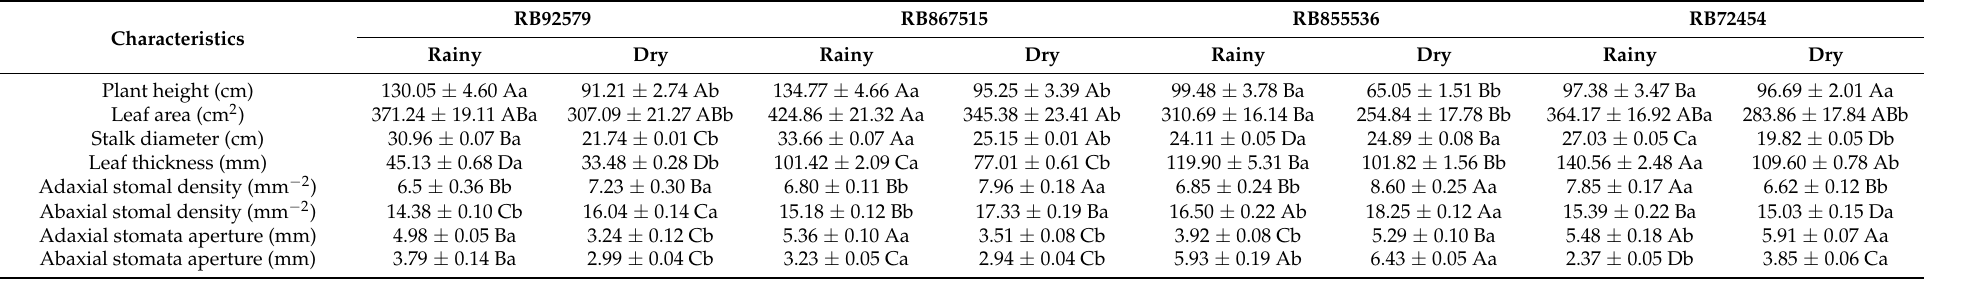
Table 3. Morphological and anatomical features of four varieties (RB92579, RB86751, RB855536, and RB72454) of sugarcane. The evaluations were made in rainy capital letters denote significance within varieties for the same season. All value denotes median ± SE (n =